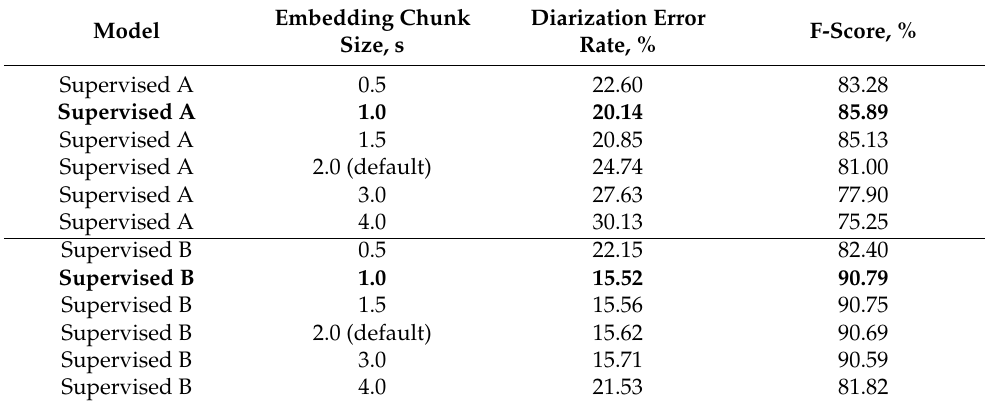
Table 4. Experiment 4